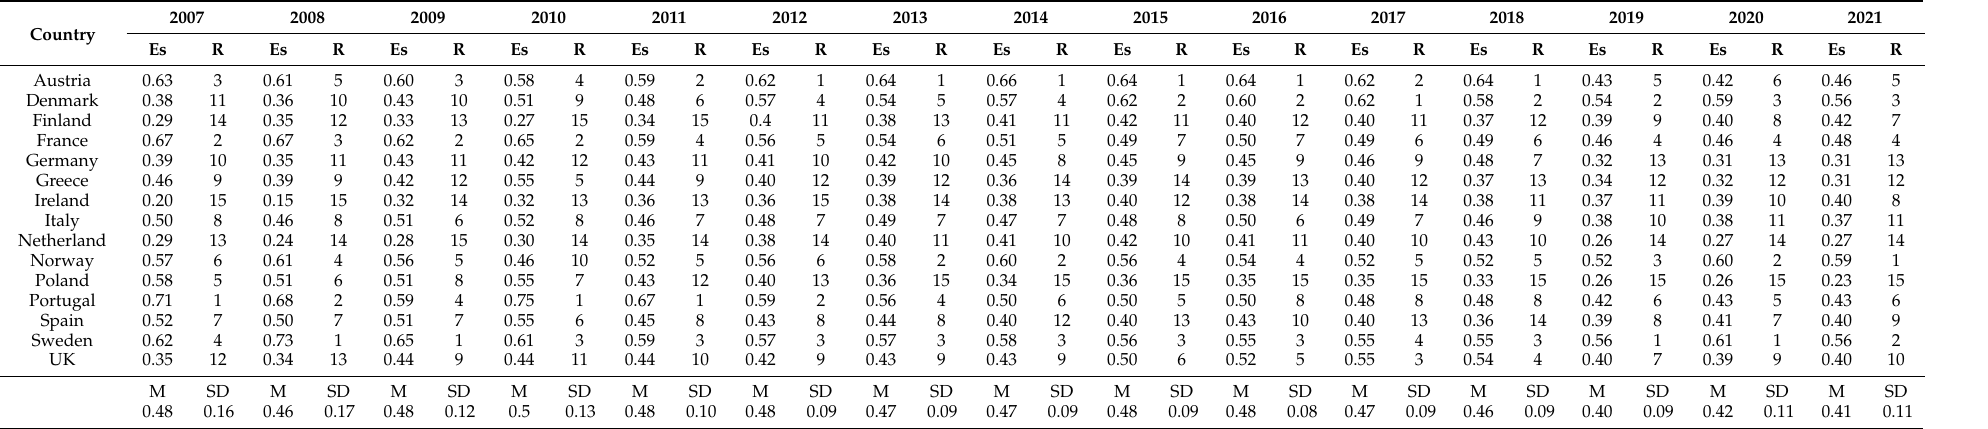
Table 1. Energy Sustainability Development (SISED) indices and